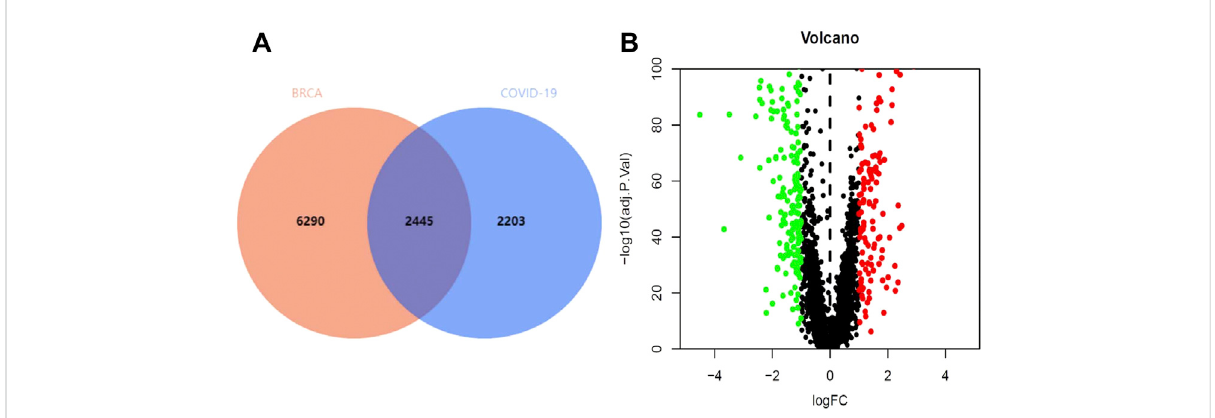
FIGURE 2 Intersection genes in BRCA/COVID-19. (A) Venn diagram of intersecting genes in BRCA/COVID-19. (B) Volcano plot of differential gene expression.